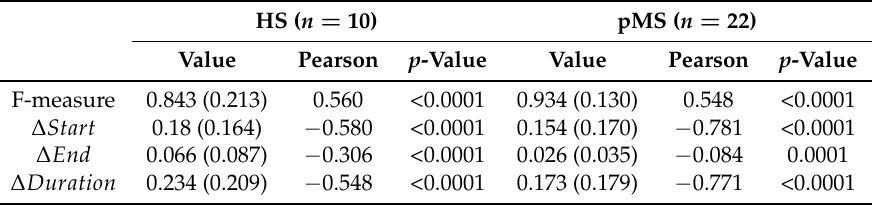
Table 3. Correlations between SId and the F-measure and accuracy scores for the step detected. All configurations are pooled together and reported as mean